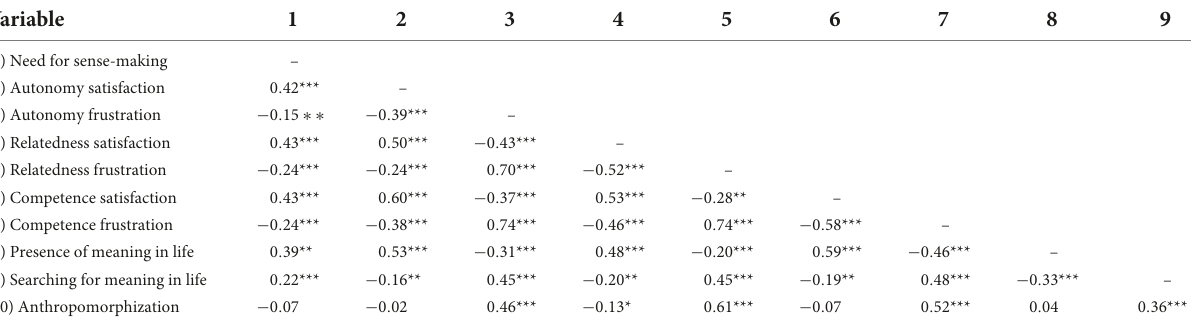
TABLE 3 Correlation matrix for Study 4.